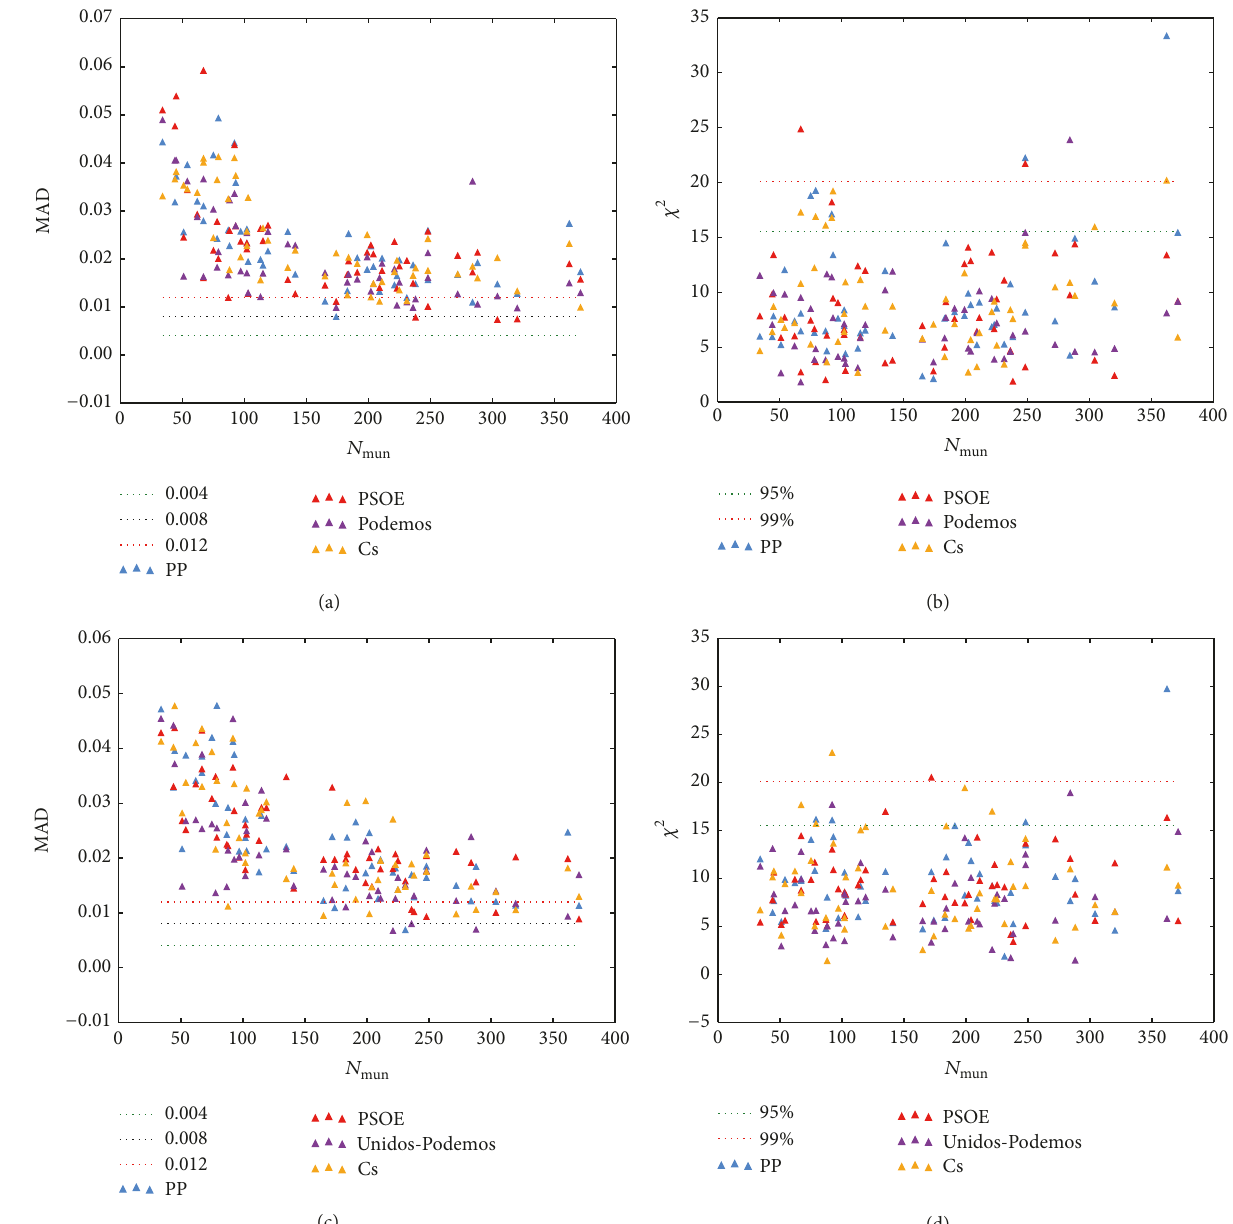
Figure 13: Scatter plot of the MAD (a, c) and 𝜒 2 (b, d) statistics extracted from the 1BL test of each precinct as a function of the number of municipalities in each precinct for years 2015 (a, b) and 2016 (c, d). In the case of MAD, we find a negative correlation as expected, but this correlation is not enough to explain the systematic nonconformance to 1BL. In the case of 𝜒 2 there is no perceivable size